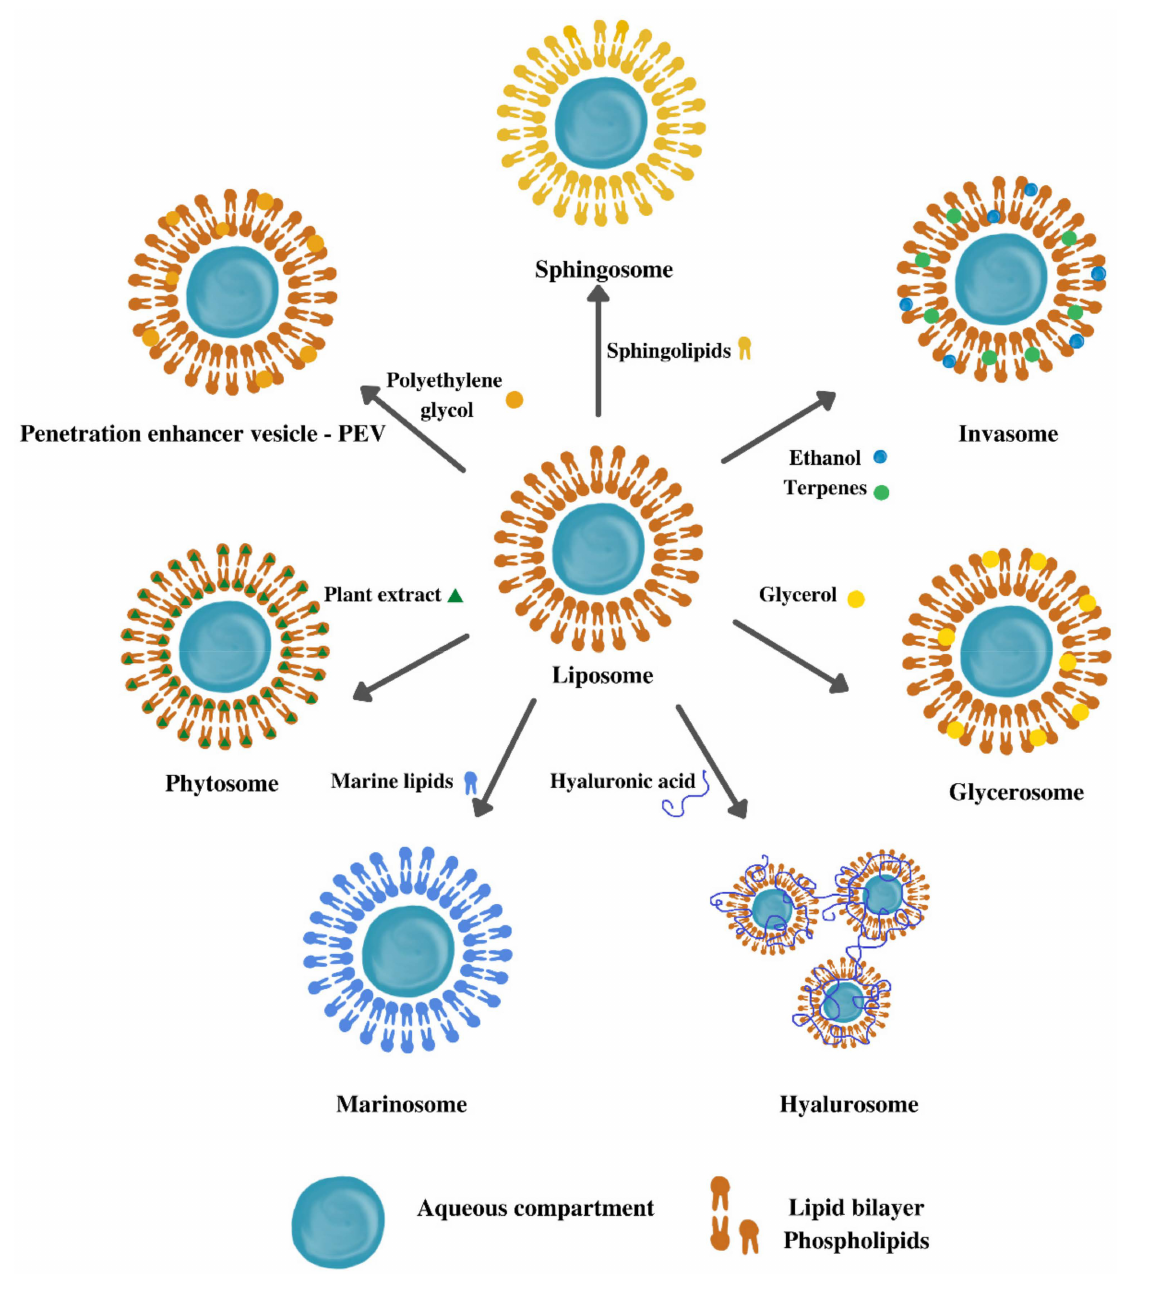
Figure 4. The main liposome derivates